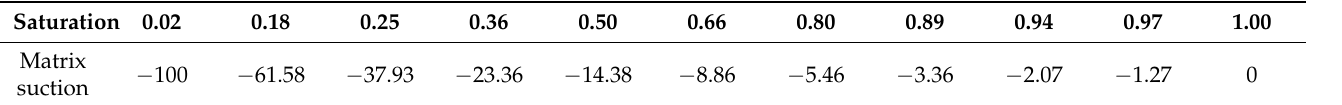
Table 1. Saturation and matrix